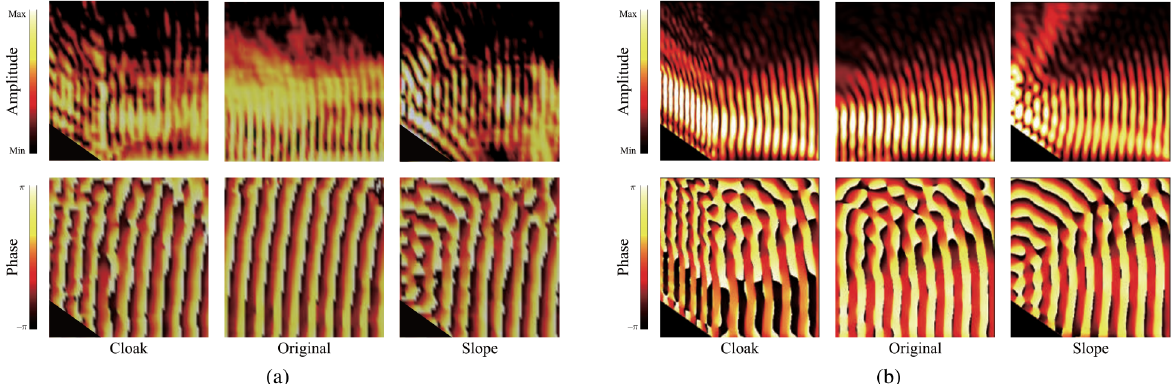
Fig. 4. Measured and simulated fi eld distributions for the incident angle of u inc =0 (cid:4) (@18.3 GHz). (a) Measured results. (b) Simulated results by the circuit simulations. The upper and lower rows represent complex amplitude and phase distributions, respectively. The left, center, and right columns represent fi eld distributions for the cloak, the original area, and the slope, respectively.